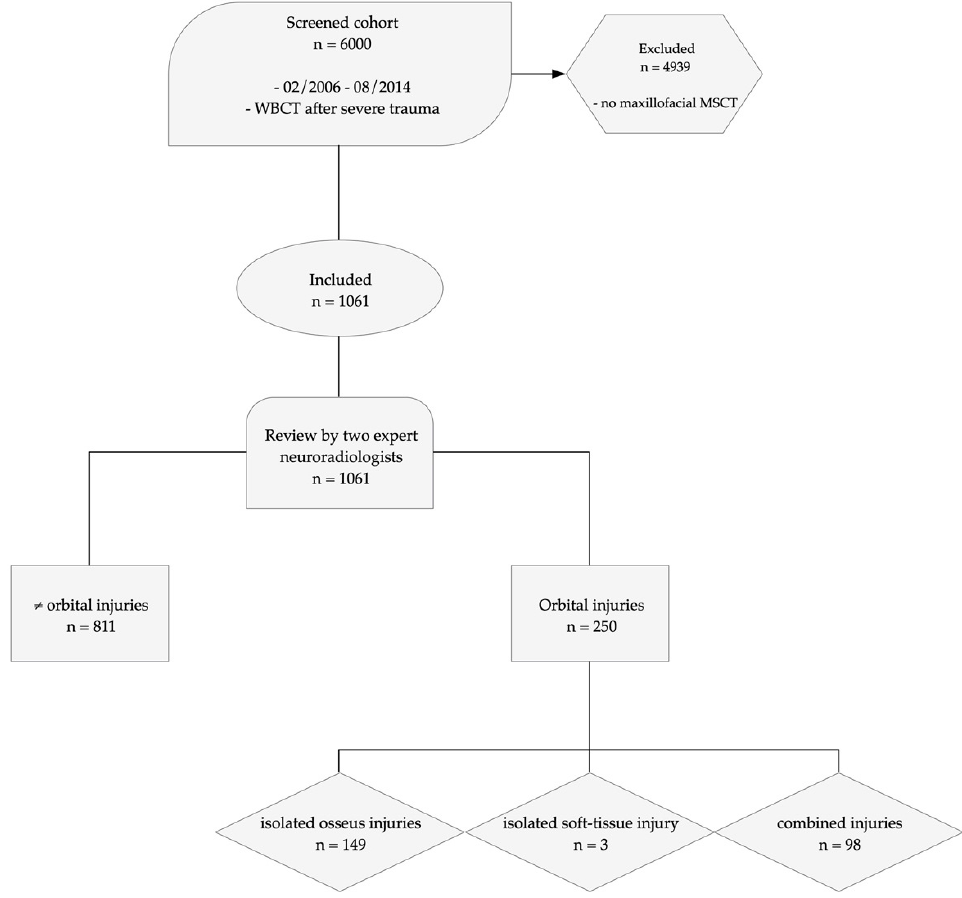
Figure 1. Study protocol visualizing the workflow according to the recommendations of the STROBE—Strengthening the Reporting of Observational Studies in Epidemiology Initiative [19] showing patient screening, inclusion, exclusion, and the results of analysis by two neuroradiologists (WBCT = whole-body CT, MSCT = multi-slice CT).